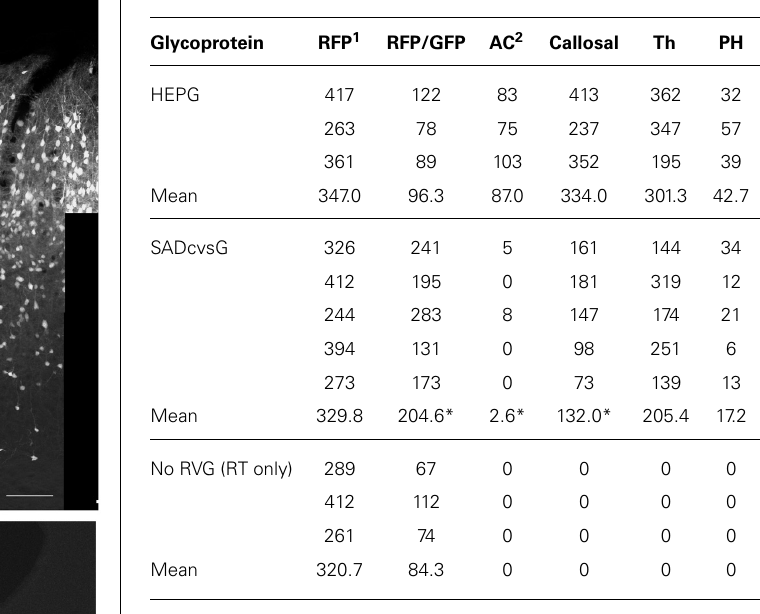
Table 1 | Quantitative analysis of traced cells with RVG variants.